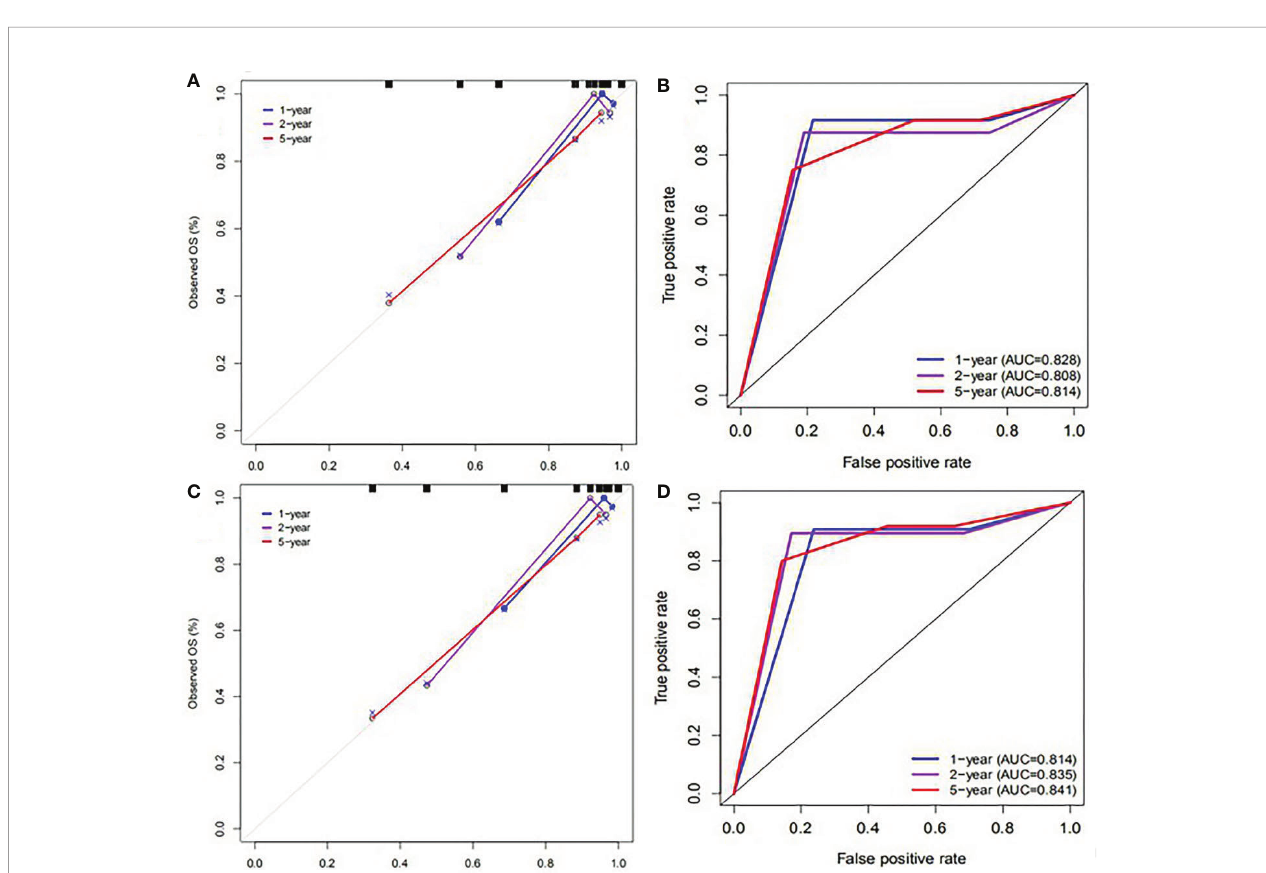
FIGURE 4 | Calibration plots and ROC curves for predicting PFS at 1-, 2-, and 5- year points. (A) The calibration plots for predicting PFS in the original model. (B) ROC curves of the nomogram for predicting PFS in the original model. (C) The calibration plots for predicting PFS in the validation model. (D) ROC curves of the nomogram for predicting PFS in the validation